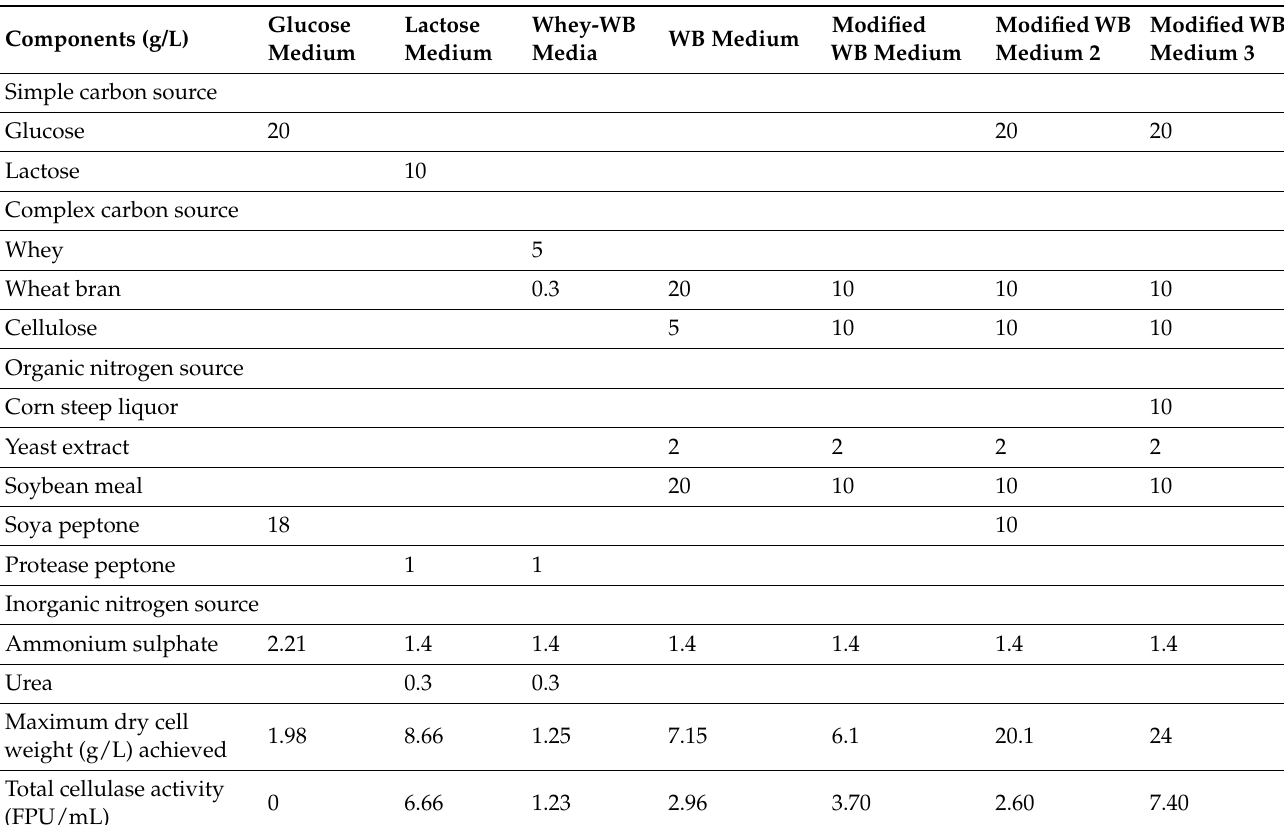
Table 1. Different carbon and nitrogen sources used in production